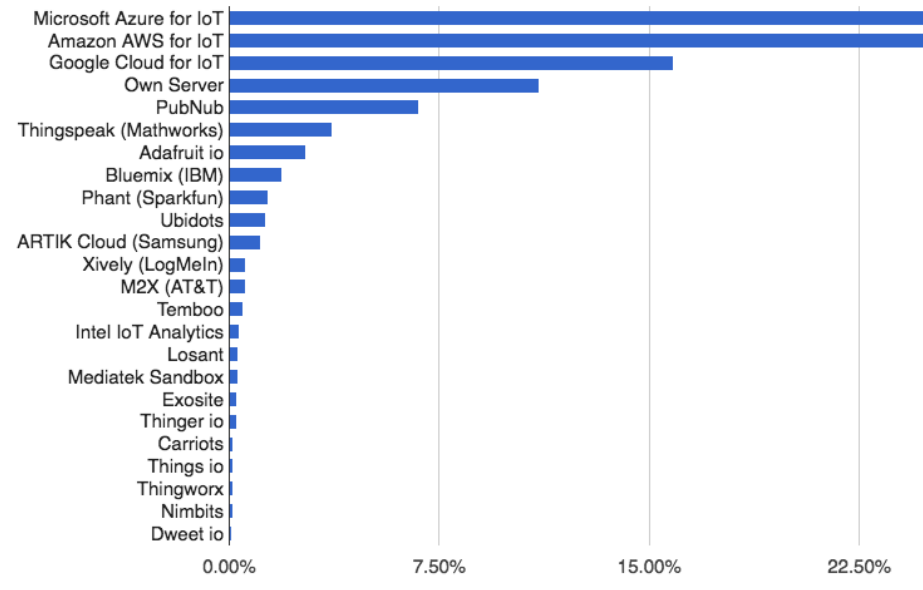
Figure 2. Top Internet of things (IoT) platforms. Source: [55].